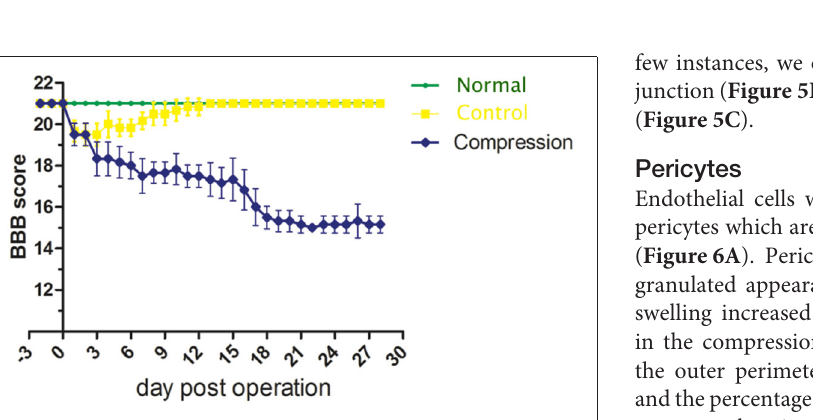
FIGURE 2 | Plot of BBB score averages from the normal, control and compression